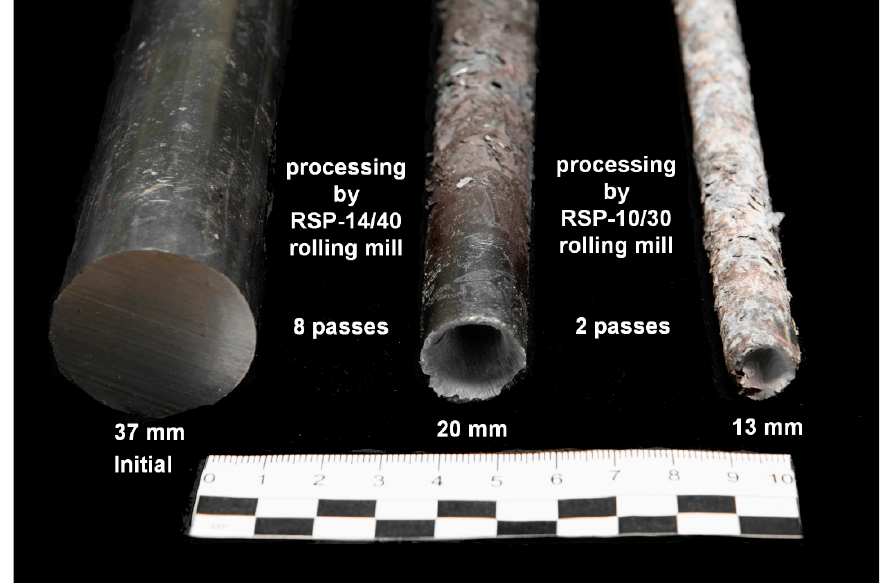
Figure 7. Samples of Zr-1%Nb alloy by rolling processing stages.